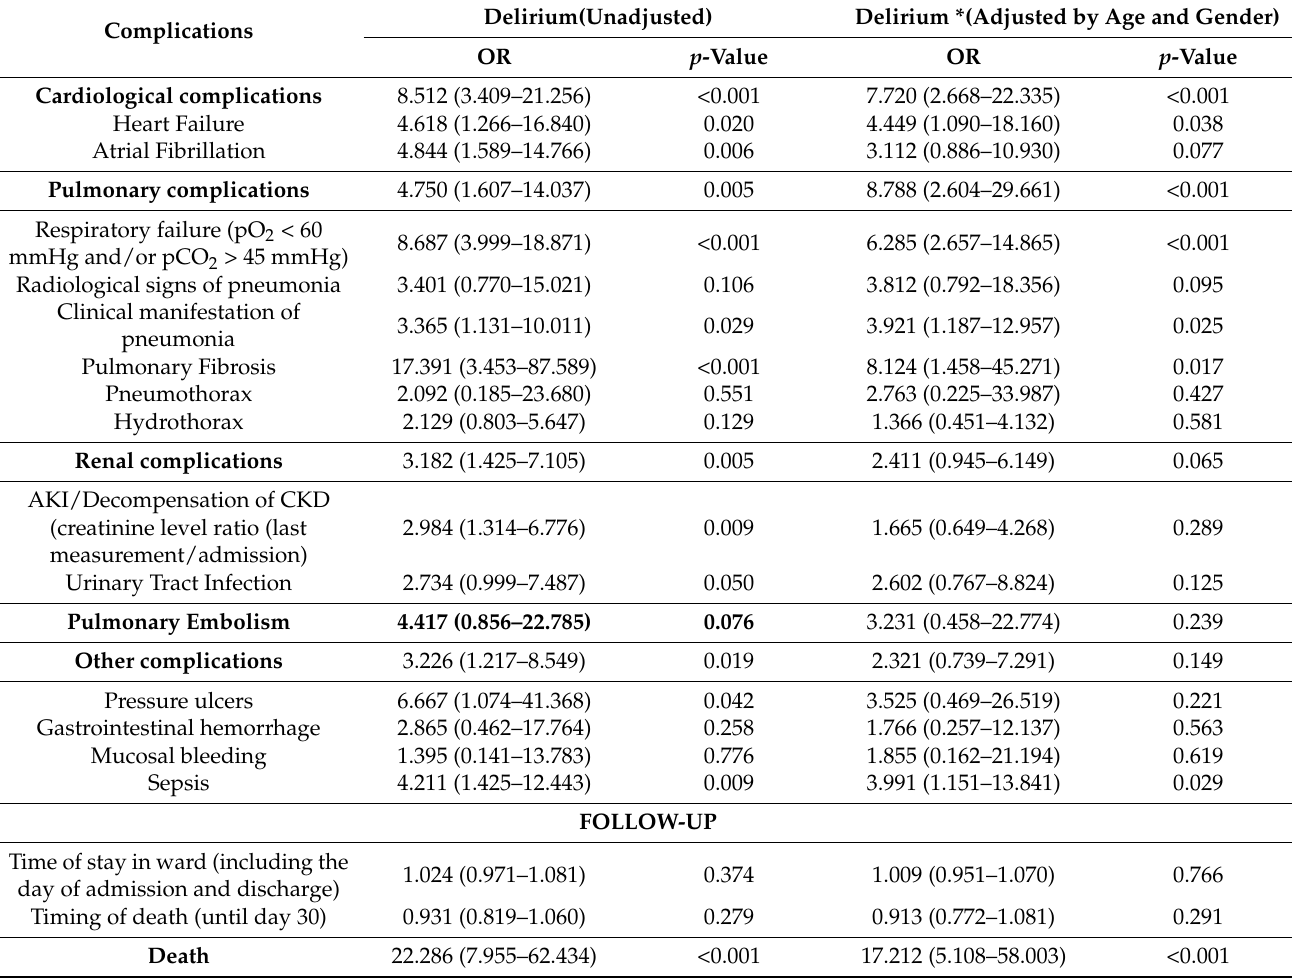
Table 8. Logistic regression for patients with impaired